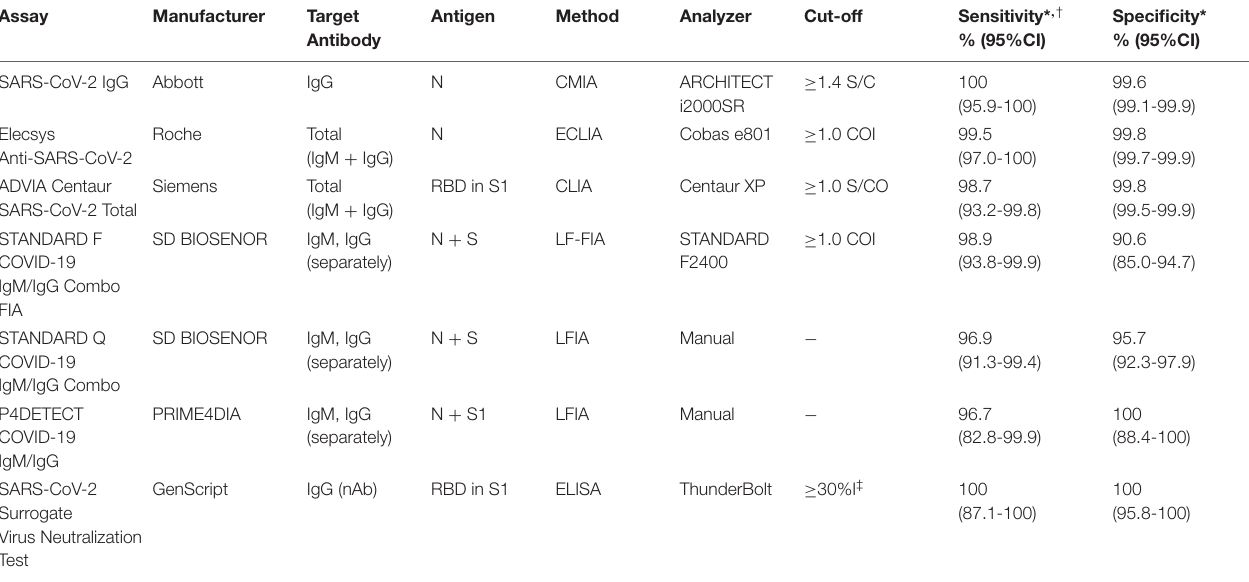
TABLE 1 | Characteristics of SARS-CoV-2 antibody assays used in this study.